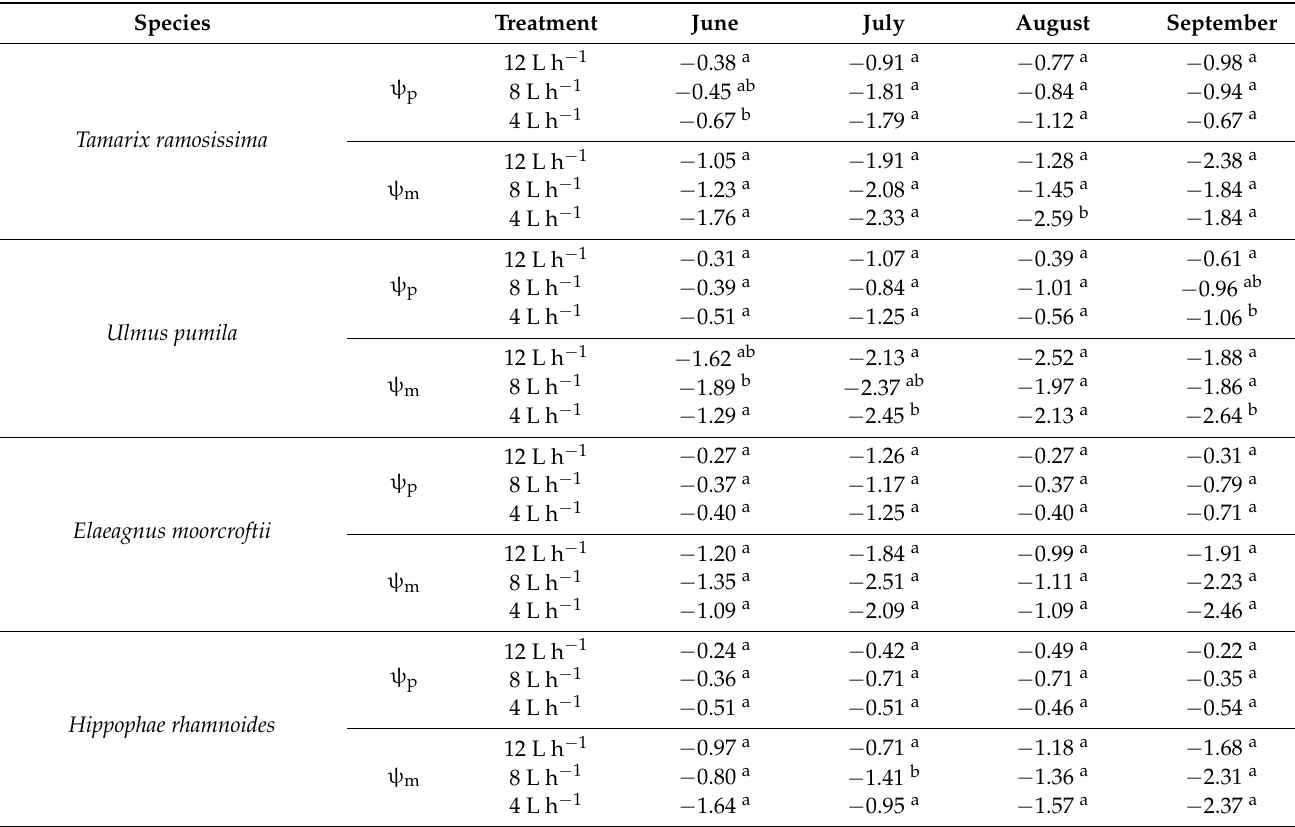
Table 2. Seasonal variation of the predawn ( ψ p ) and midday ( ψ m ) leaf water potentials in Tamarix ramosissima , Ulmus pumila , Elaeagnus moorcroftii , and Hippophae rhamnoides across different irrigation treatments measured in 2016. Different lowercase letters indicate significant differences among the treatments at α = 0.05.